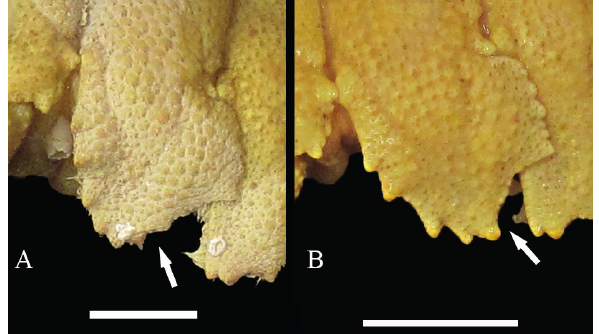
Figure 3. Lateral view of the pleura of the second abdominal somite of Scyllarides deceptor Holthuis, 1963. A, female (MNHNM 1952). B, male paratype (USNM 105810). White arrows indicate the differences on the margins. Scale bars: 1